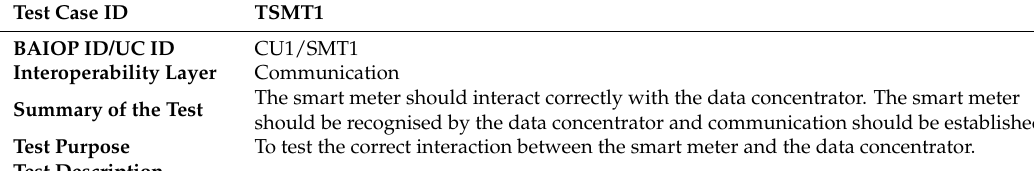
Table 2. Basic Application Interoperability Profiles (BAIOPs) for the communication layer, based on [18]. Test Case